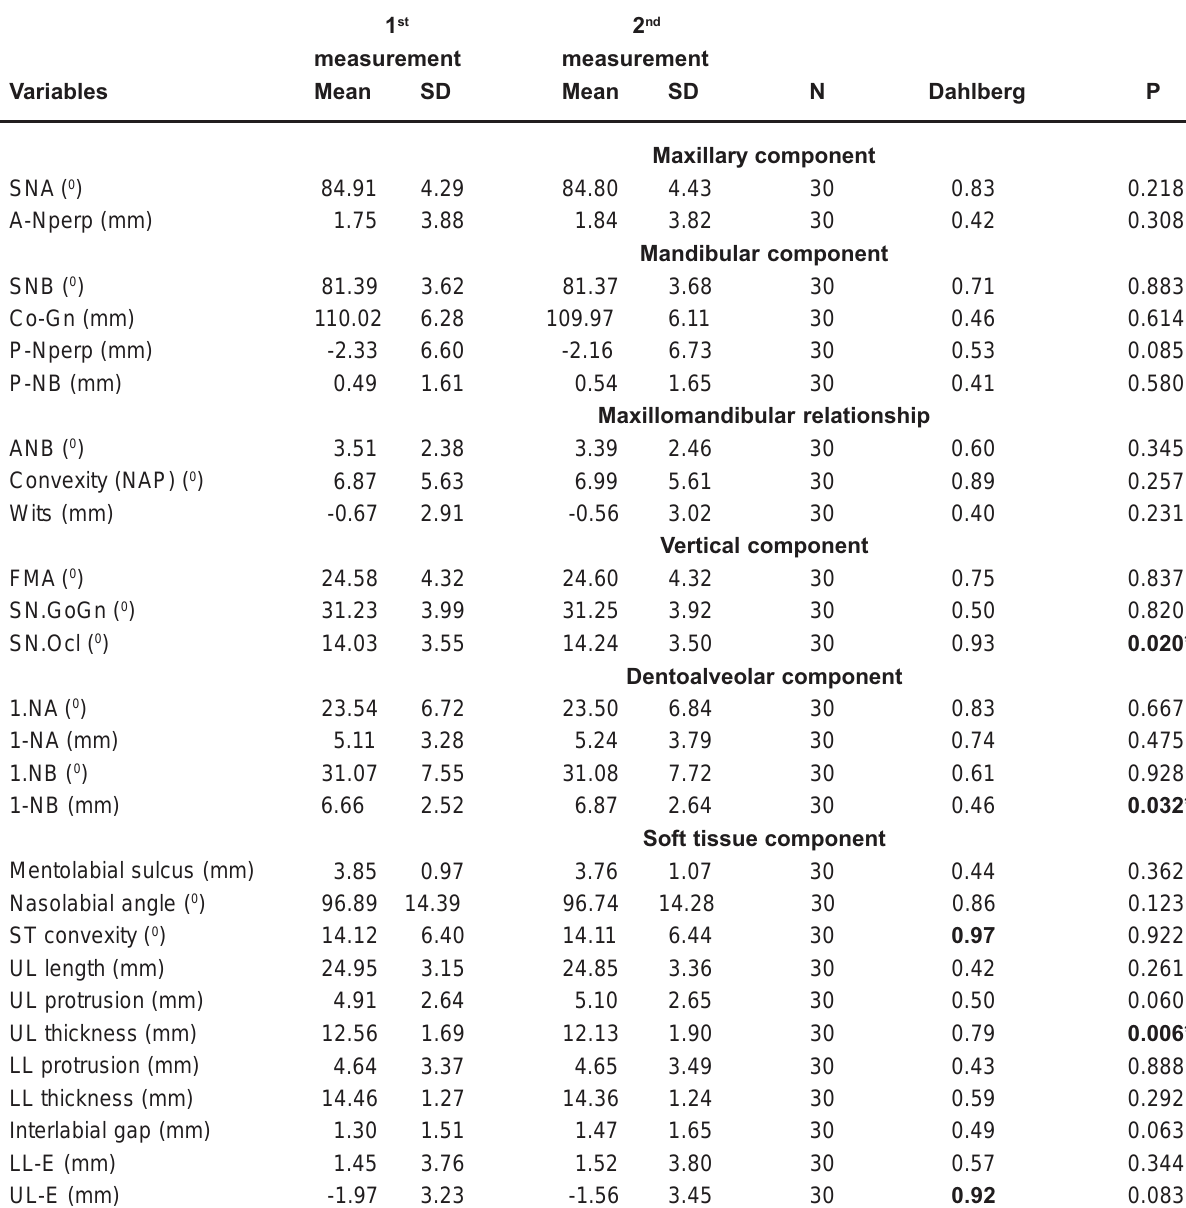
* Statistically significant for P <.05. SD = standard